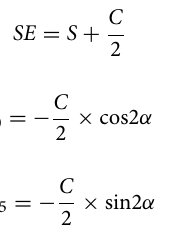
the treated/right eyes of treatment and normal groups. At the end of the experiments, chicks were sacrificed by inhalation of carbon dioxide after the mfERG recordings. Hartinger coincidence refractometer.